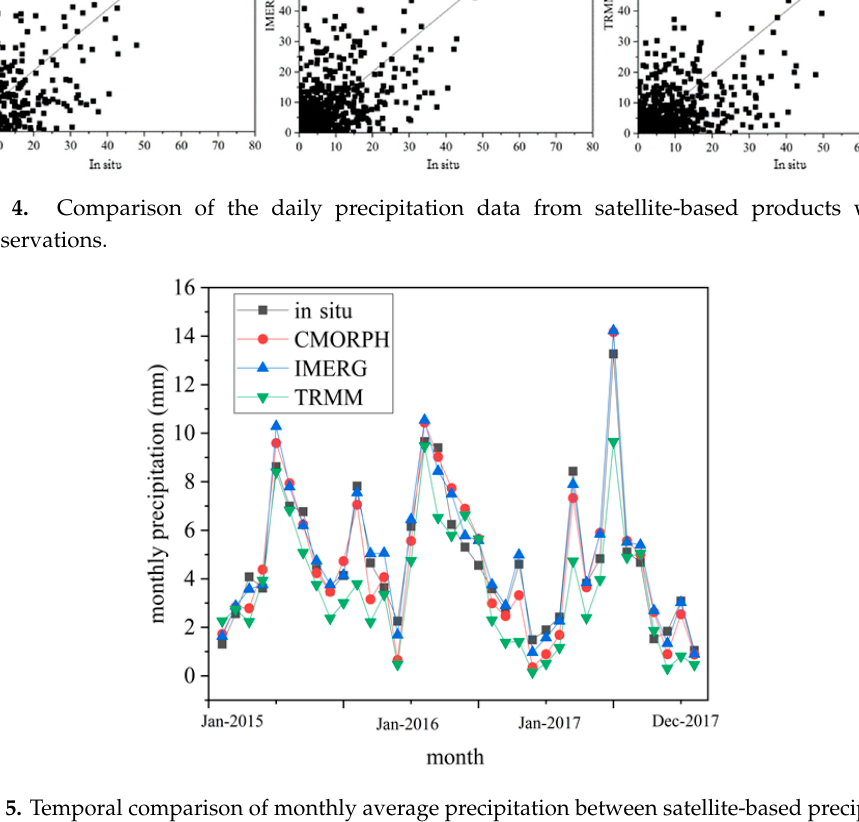
Figure 5. Temporal comparison of monthly average precipitation between satellite-based precipitation products and in situ observations.